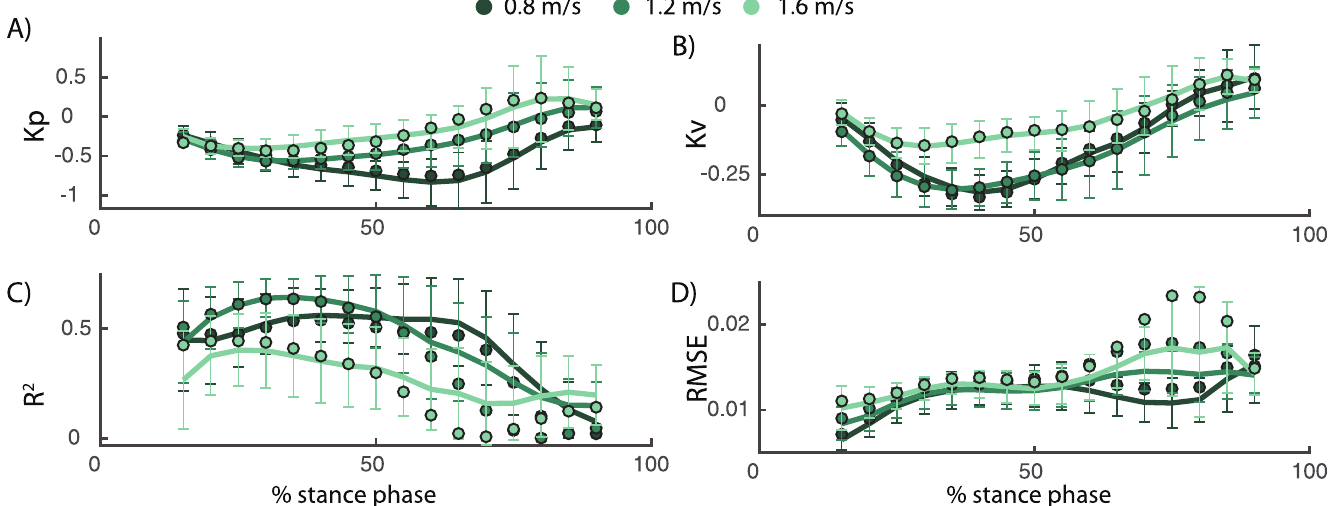
Fig 8. Continuous treadmill perturbations walking (data from [27]). The COM position (A) and velocity (B) feedback gains describing the reactive ankle joint moment depend on the walking speed. Both the position and velocity gains decrease with increasing walking speed. R 2 values decrease and RMSE increase with increasing walking speed, indicating a worse fit of the feedback model as walking speed increases. The errorbars and lines represent the average and standard deviation of the fit for individual subjects, the dots represent the results from the analysis based on pooled data over all subjects.